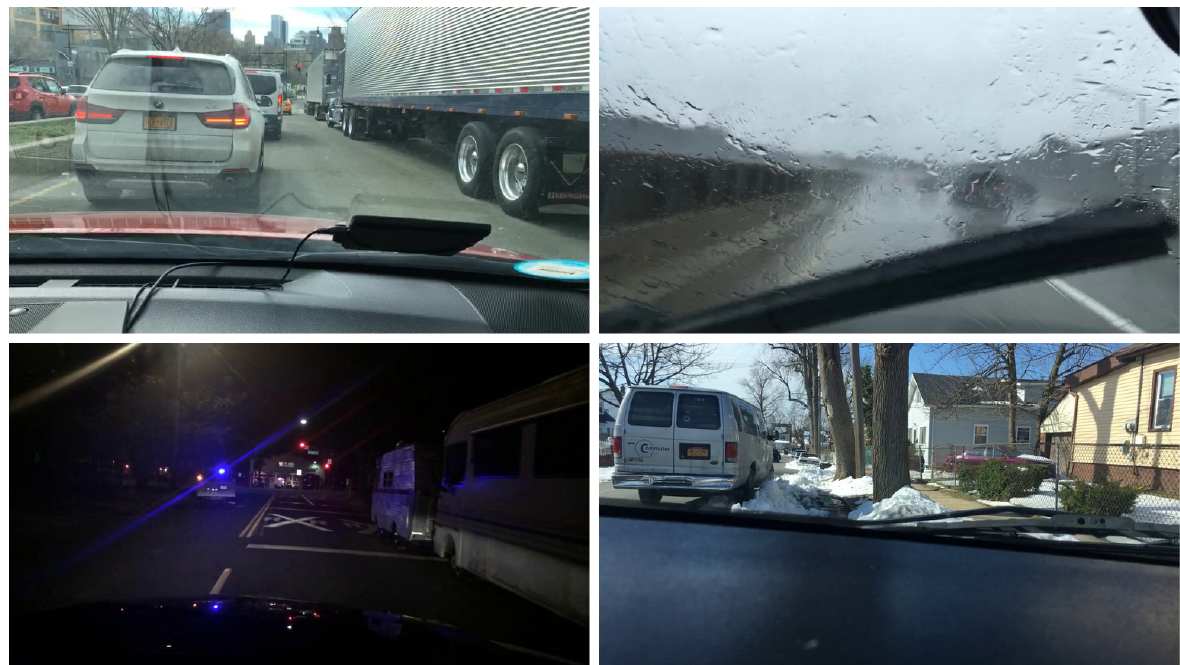
Figure A8. Image samples from BDD100K